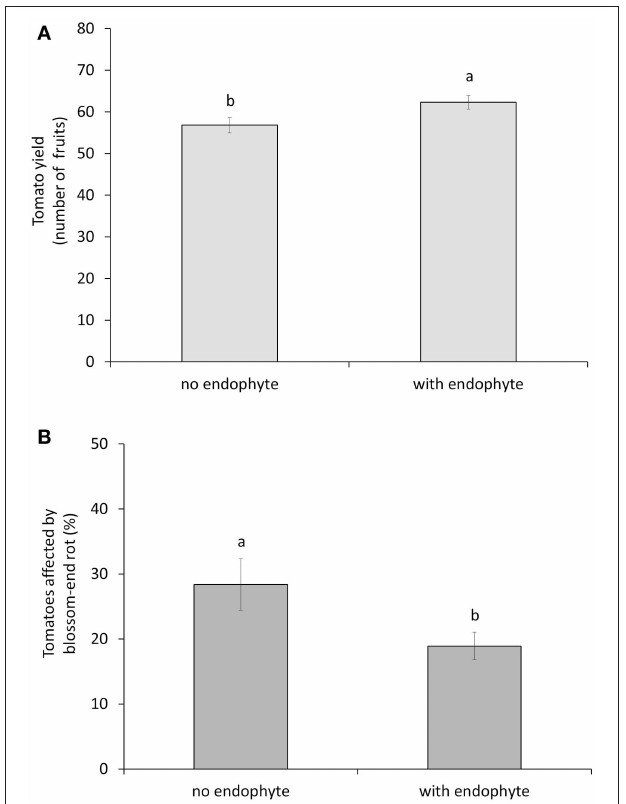
FIGURE 3 | Survival (A) and reproduction (B) of the predator Macrolophus pygmaeus on tomato plants treated with the endophyte Fo162, the supplemental food source Artemia franciscana or a combination of both compared to untreated plants. Shown is the mean ( ± SE) percentage of survival of 24 released adult predators 2 weeks after their introduction (A) and the mean ( ± SE) total number of first, second and third nymphal stages (n1, n2, n3) produced (B) . Different letters above bars indicate significant differences among treatments (Fisher’s LSD-tests, p <